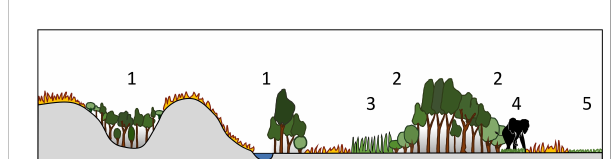
FIGURE 5 Natural protection of forest patches from fi res in open, fl ammable landscapes. 1. Topographic refuge and barriers to fi re spread 2. Fire-tolerant protective woody margins 3. Low fl ammability grass margins 4. Footpath fi rebreak margins 5. Low fl ammability grazing